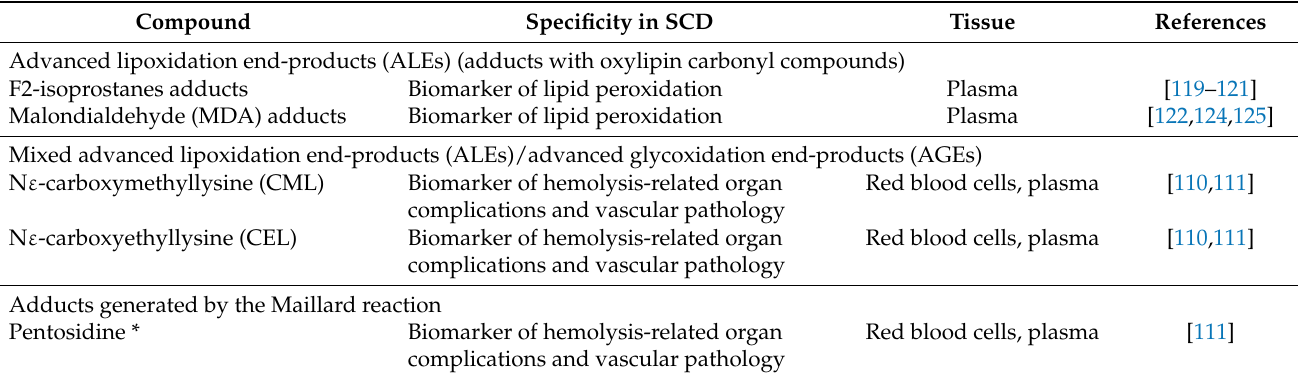
Table 1. Oxidative modifications of red blood cell (RBC) and plasma proteins detected in patients with SCD.